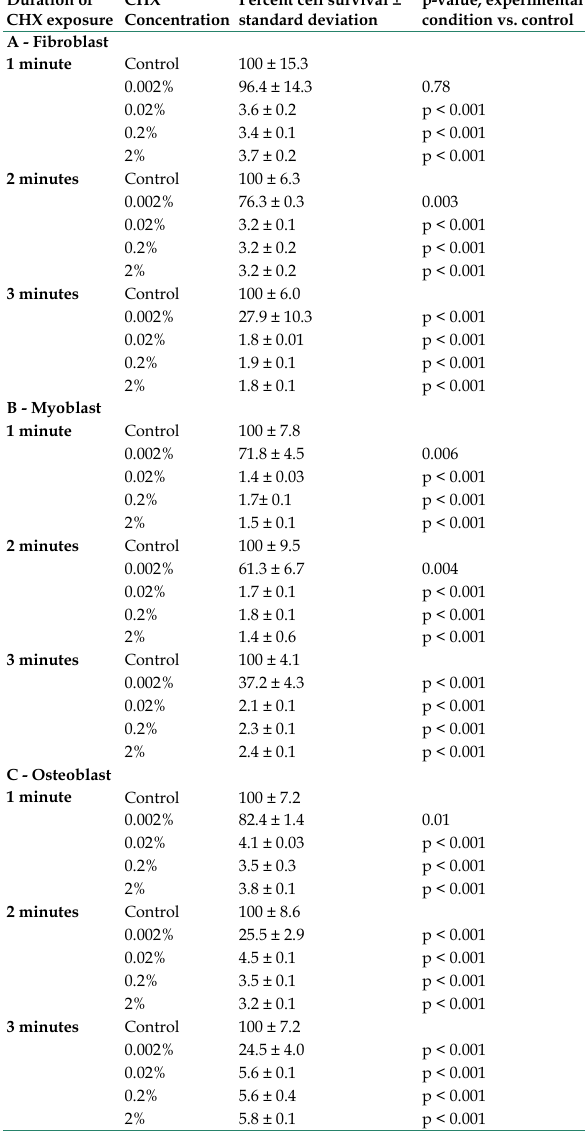
Table 1: Percent survival of cells 48 hours after exposure to different concentrations of chlorhexidine gluconate for 1, 2, and 3-minute durations. A) Fibroblast B) Myoblast C) Osteoblast. Duration of CHX Percent cell survival ± p-value, experimental CHX exposure Concentration standard deviation condition vs. control